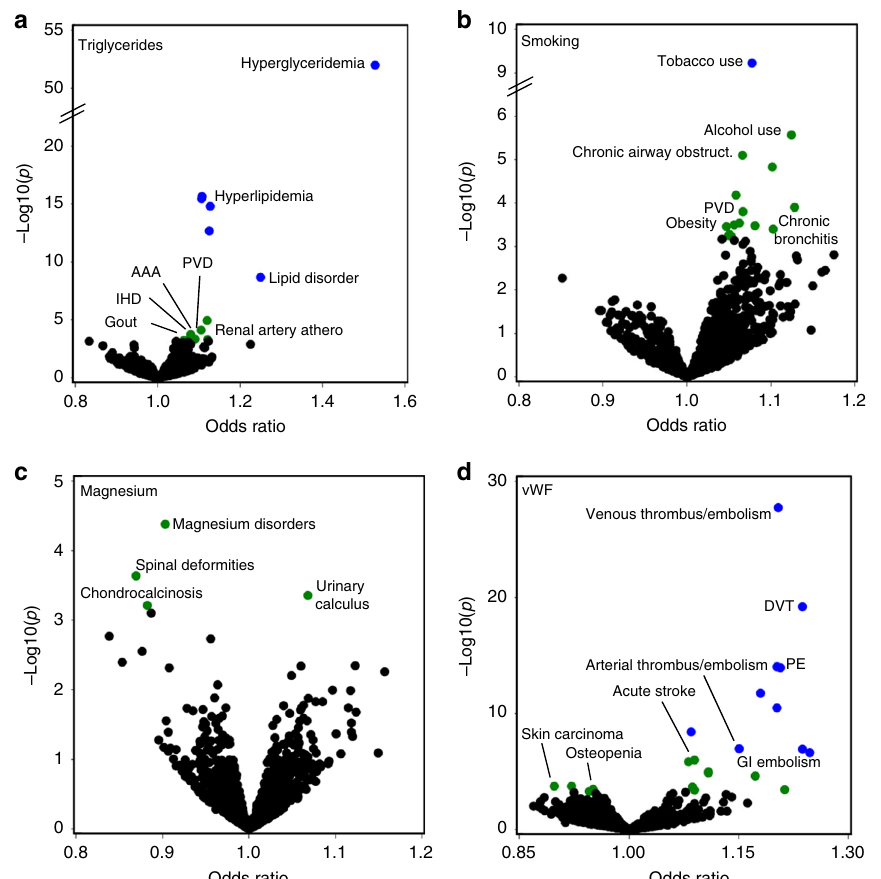
Fig. 4 Associations for selected biomarkers. Scatter plots summarizing pheWAS analyses for genetic predictors of a triglyceride levels, b pack-years of smoking, c serum magnesium levels, and d serum Von Willebrand factor levels. Odds ratios are from logistic regression analyses, adjusting for birth decade, sex, and 3 PCs. Blue and green colored circles denote associations that are signi fi cant at Bonferroni p < 0.05 and FDR q < 0.1, respectively. PVD: peripheral vascular disease; AAA: abdominal aortic aneurysm; IHD: ischemic heart disease; DVT: deep vein thrombosis; PE: pulmonary embolism;